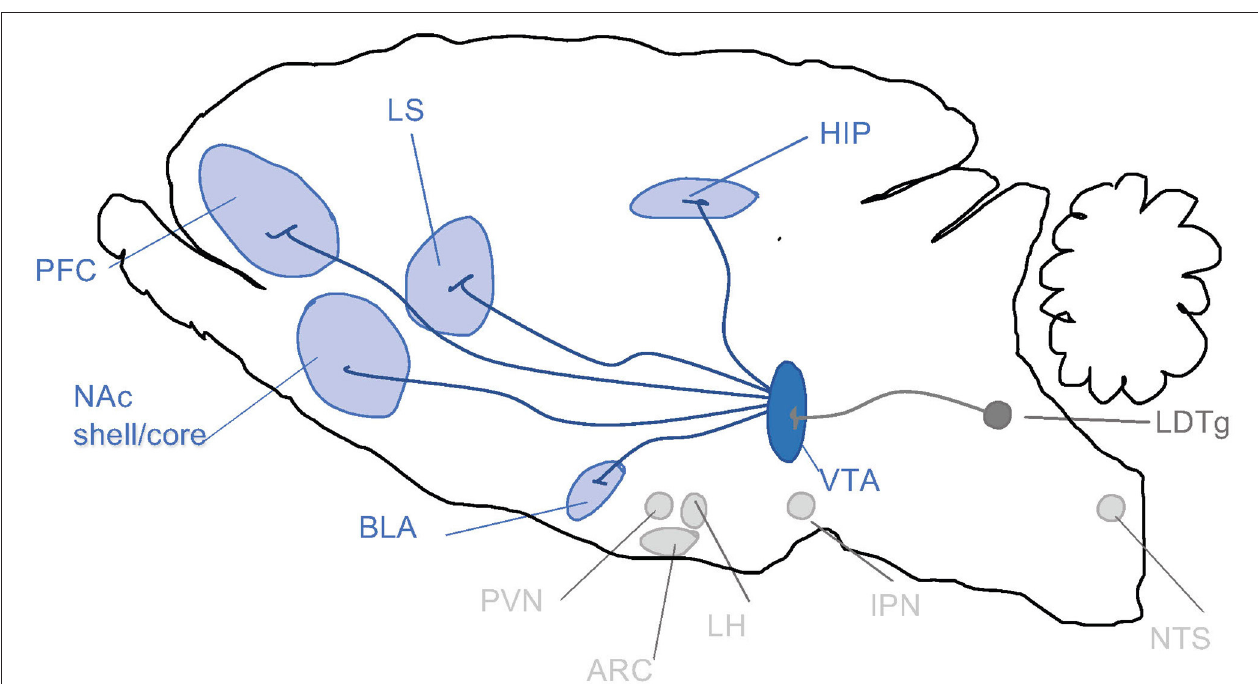
FIGURE 2 | Schematic illustrations of some selected brain regions central for addictions. Dopamine neurons of the ventral tegmental area (VTA) project (dark blue) to brain regions such as prefrontal cortex (PFC), nucleus accumbens (NAc) subdivisions core and shell, basolateral amygdala (BLA), lateral septum (LS) and hippocampus (HIP). Alcohol and other drugs of abuse dopamine release in such areas, which is associated with reward/stimulation/euphoria. Several of these areas are targeted by nucleus tractus solitarii (NTS) of the brain stem. Both the VTA and NAc shell are targeted by the projections from laterodorsal tegmental area (LDTg), which to some extent are cholinergic (dark gray). Another selected area of interest include paraventricular nucleus (PVN), arcuate nucleus (ARC) and lateral hypothalamus (LH) and interpeduncular nucleus